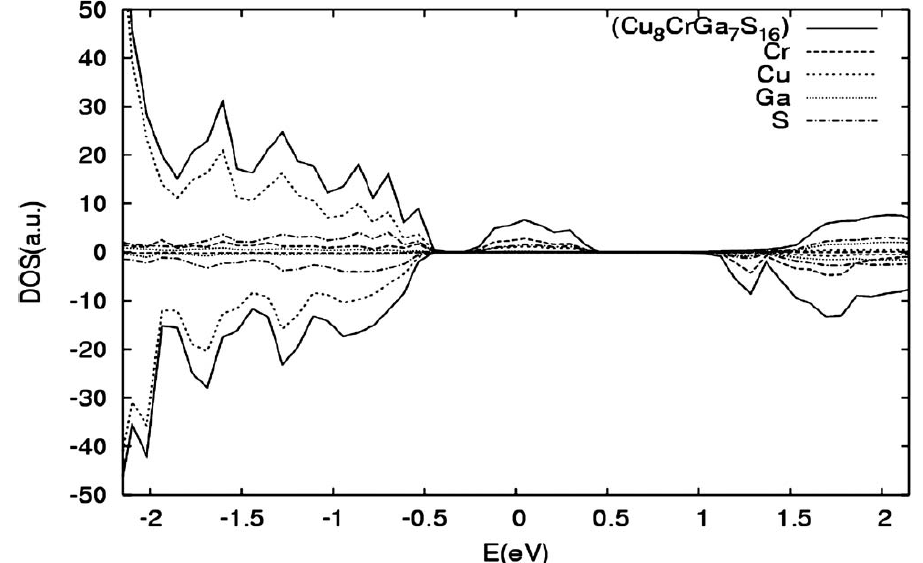
Figure 11. DOS of a chalcopyrite-doped system with intermediate band gap. Figure reprinted from [147] with permission from the American Society for Mechanical Engineering.